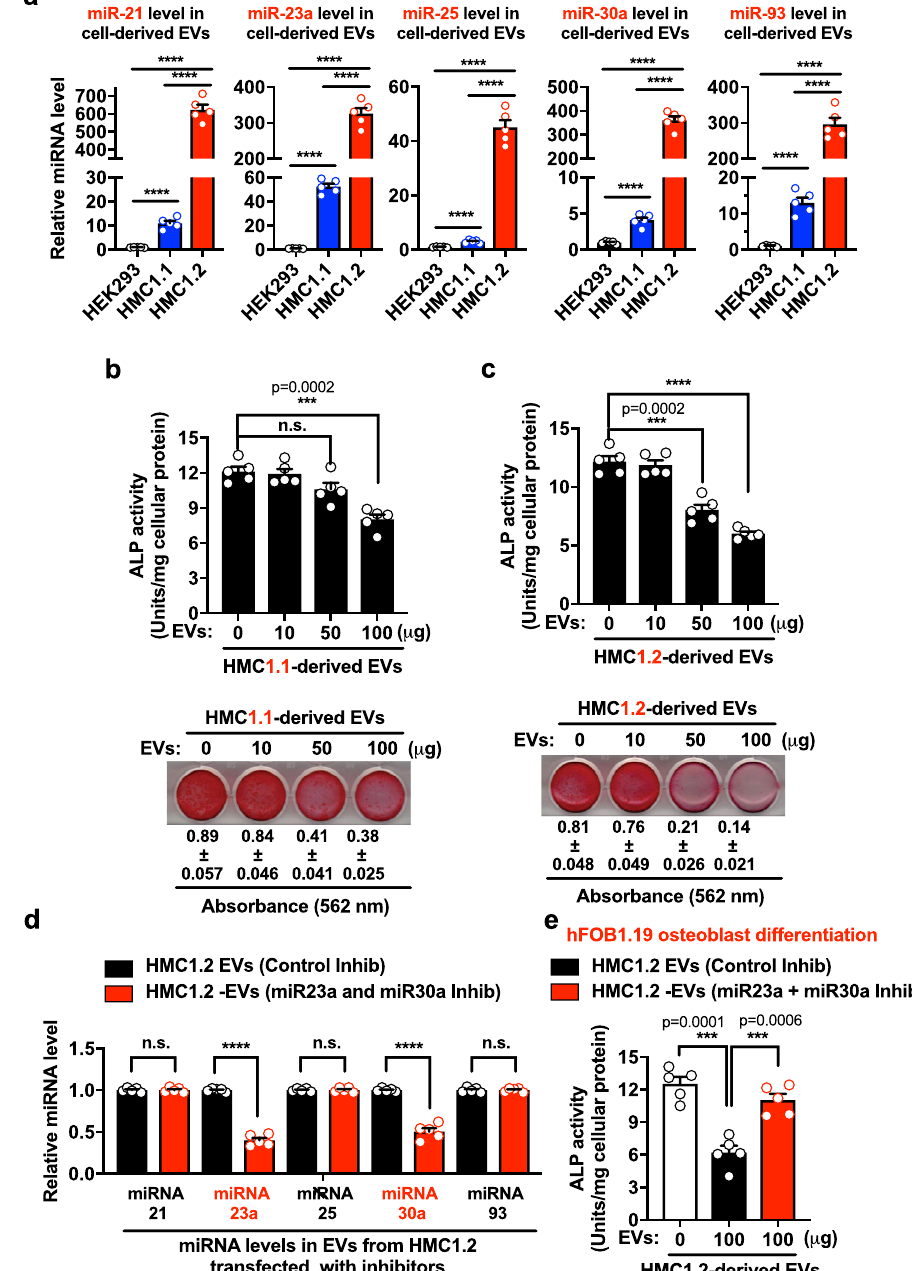
Fig. 6 Neoplastic mast cells-shed EVs inhibit osteoblast differentiation via miR-23a and miR-30a. a Expression of miR-21, mR-23a, miR-25, miR-30a, and miR-93 in extracellular vesicles (EVs) released from HEK293, or the neoplastic mast cell lines HMC-1.1 and HMC-1.2, as indicated. RNA was extracted from 100 µ g of EVs isolated from the supernatants of the cell cultures and expression levels of the indicated miRNA species (from equal amounts of total RNA) were measured by qRT-PCR and expressed as fold change of the content in EVs from HEK293 cells. b, c Effect of EVs derived from HMC-1.1 ( b ) or HMC-1.2 ( c ) in the differentiation and mineralization of osteoblasts. hFOB1.19 were plated and treated with 10, 50, or 100 µ g of EVs. At the end of 12 days, alkaline phosphatase (ALP) activity (bar graphs in b and c ) was measured. The presence of calcium deposits by staining with alizarin red staining was also determined ( b and c , lower panels). d Levels of miRNAs in the EVs of HMC-1.2 cells after transfection of these cells with antisense oliogonucleotides inhibitors (inhib.) for miR-23a and miR-30a (miR-23a and miR-30a inhib; red bars) or with control oligos (control inhib; black bars). Levels of the indicated miRNAs were determined by qRT-PCR as in a . e Effect of EVs derived from miR-23a- and miR-30a-silenced HMC-1.2 cells on osteoblast differentiation. Osteoblast (hFOB1.19) cultures were treated or not (white bar, untreated cells) with 100 µ g of EVs from HMC-1.2 transfected with control oligos (HMC- 1.2-EVs (Control inhib.), black bar) or HMC-1.2 transfected with miR-23a and miR-30a inhibitors ((HMC-1.2-EVs (miR-23a + miR-30a inhib.), red bar). ALP activity was determined after 6 days. Data in a – e are the mean ± SEM ( n = 5 biological replicates) of a representative experiment out of three experiments with similar results. In a – e *** p < 0.001; **** p < 0.0001; and n.s., not signi fi cant, using unpaired Student t -tests (two-tailed).